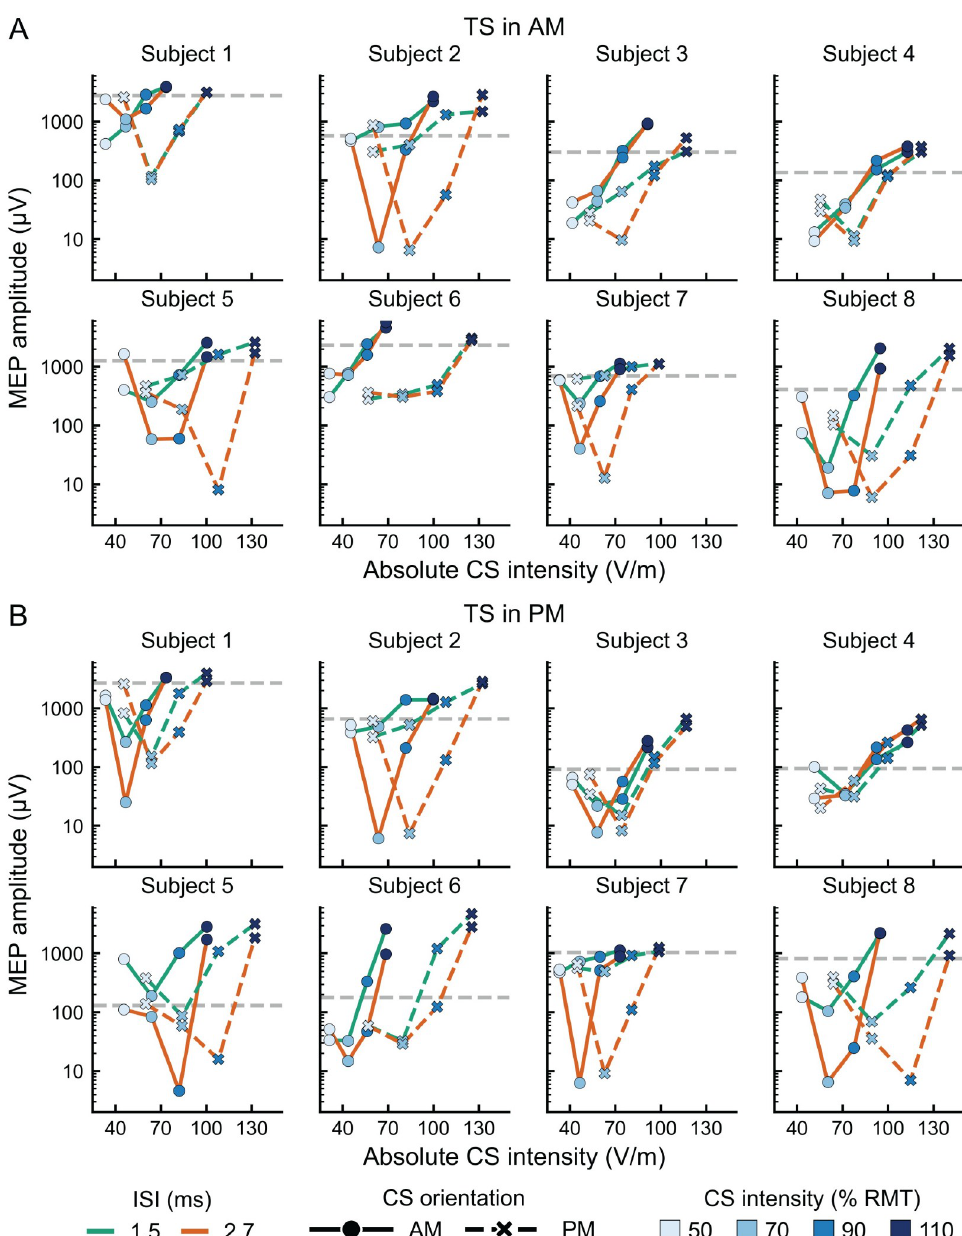
Fig 3. MEP amplitude as a function of the absolute CS intensities in V/m. TS in (A) AM and (B) PM orientations. The absolute CS intensities were computed as the RMT multiplied by the CS rising-phase duration (see Table 1). The absolute E-field intensities are subject-specific, thus, the data for each subject are presented in separate charts. The dashed, gray horizontal lines indicate the median amplitude of 20 single TS pulses. curve for the CS in the PM orientation is shifted to the right by the orientation-specific differ- ence compared to the SICI intensity curve for the CS in the AM orientation. The CS threshold for SICI is lower than the MEP threshold [8,10] but correlates with it [49]. It has been shown that SICI can be induced with a weaker stimulus intensity compared to the RMT and that the SICI threshold and different levels of inhibition along the SICI intensity curve correlate with